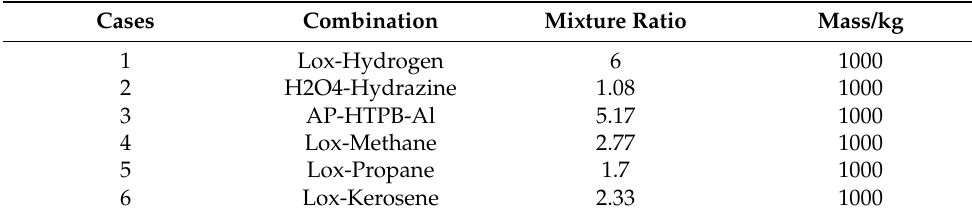
Table 2. Experimental cases.